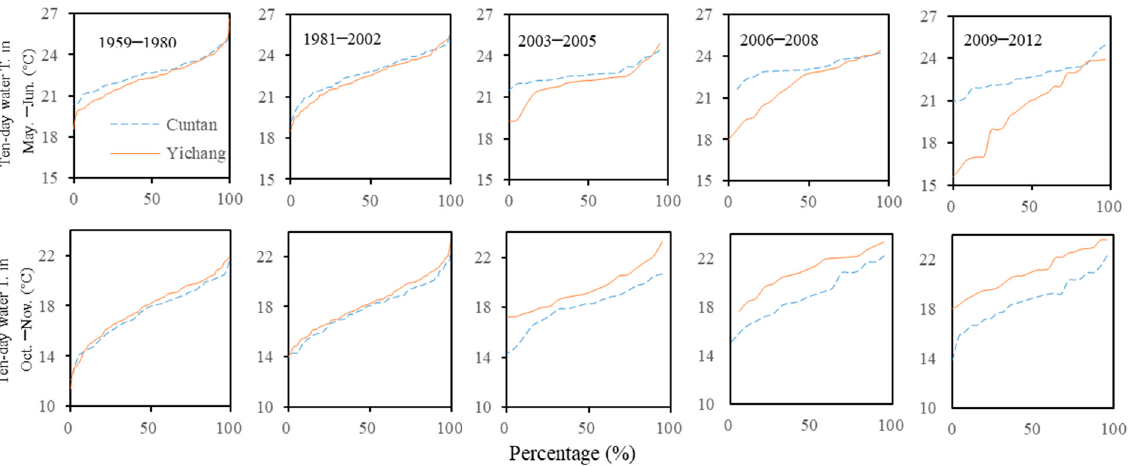
Figure 7. Frequency distributions of the daily water temperature in May–June and October– November during different periods.